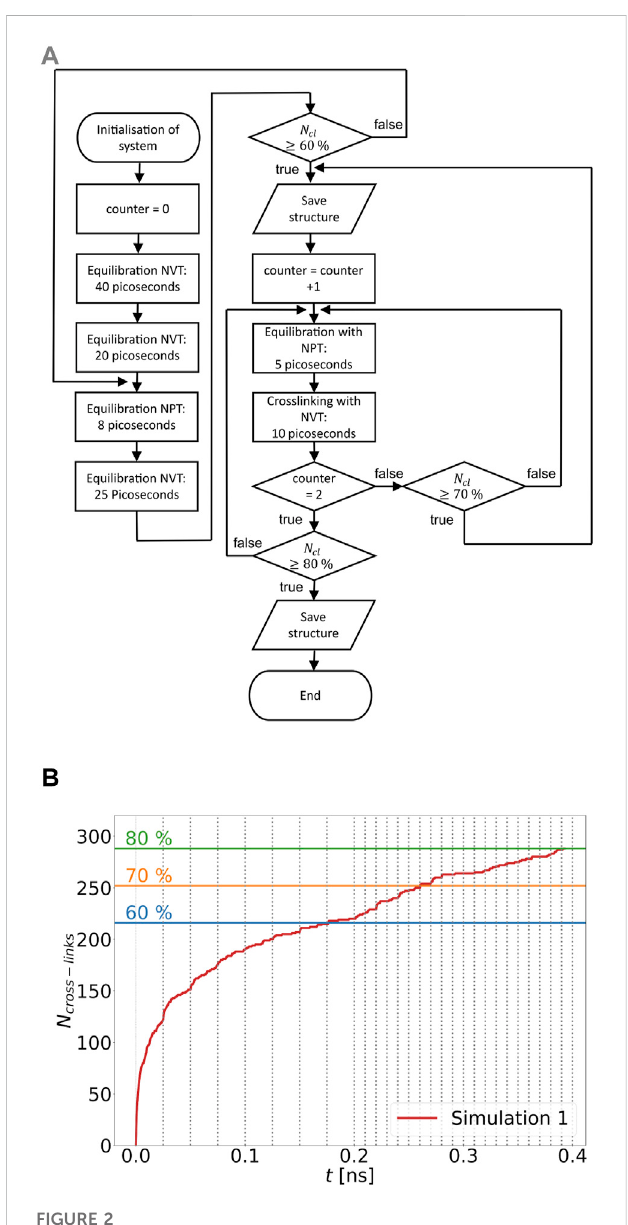
FIGURE 2 (A) Flowchart of distance based cross-linking procedure; (B) Progressofcross-linkingovertimeforasimulationrunofasystemwitha chainto linkerratio of5to 3:Threethresholdvalues ofnumberofcross- linksaredisplayedfor60%,70%,and80%cdc.Thegreydottedlines mark the start and end points of the cross-linking